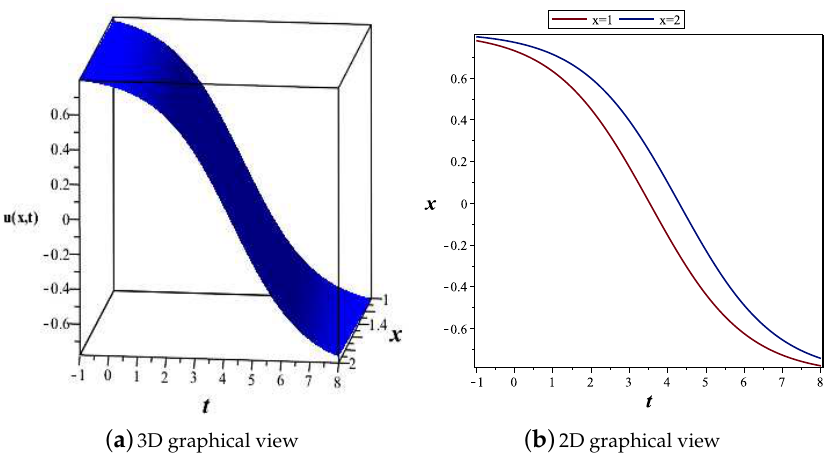
Figure 6. Graphical representation of Equation (44) within interval 1 ≤ x ≤ 2 and − 1 ≤ t ≤ 8 (( a ) 3D plot, ( b ) 2D plot for t = 1,